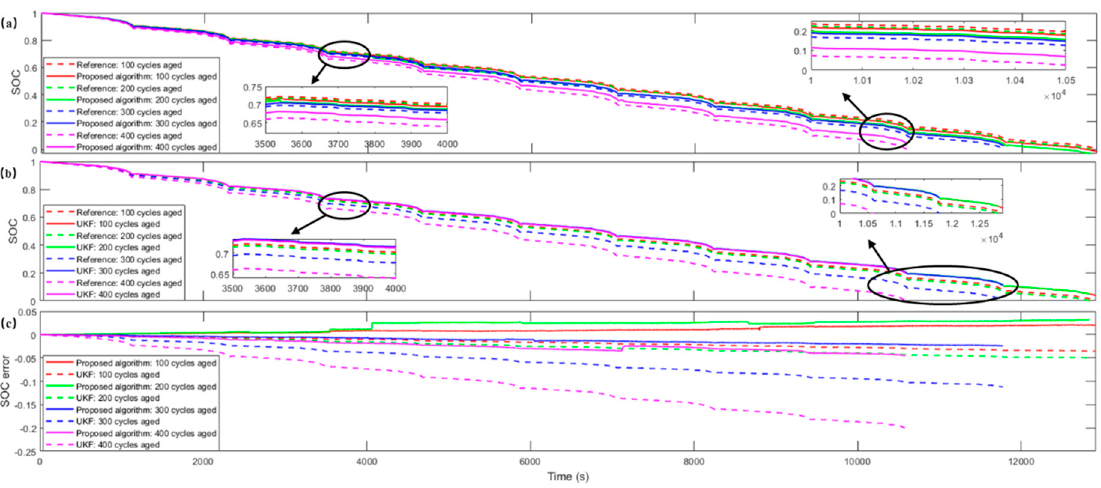
Figure 11. The SOC estimation results in aging process. ( a ) Estimated SOC of proposed method, ( b ) estimated SOC of unscented Kalman filter (UKF), and ( c ) SOC errors. Table 5 . Comparison of the SOC estimation errors in aging process.